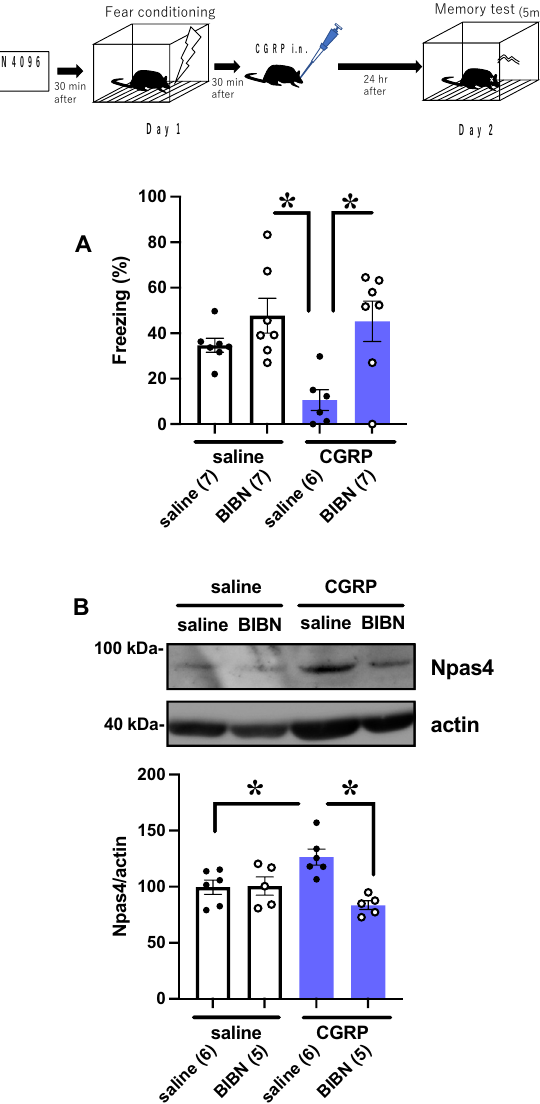
Figure 4. Intranasal CGRP attenuates fear memory retention via the CGRP receptor with an increase in Npas4 expression. ( A ) Effects of CGRP receptor antagonist BIBN4096 (1 mg/kg) on fear memory retention. ( B ) Effects of BIBN4096 on the levels of Npas4 protein expression. Each bar indicates the mean ± S.E.M. * p < 0.05, Tukey– Kramer test. Numbers in parentheses indicate the animal numbers for each